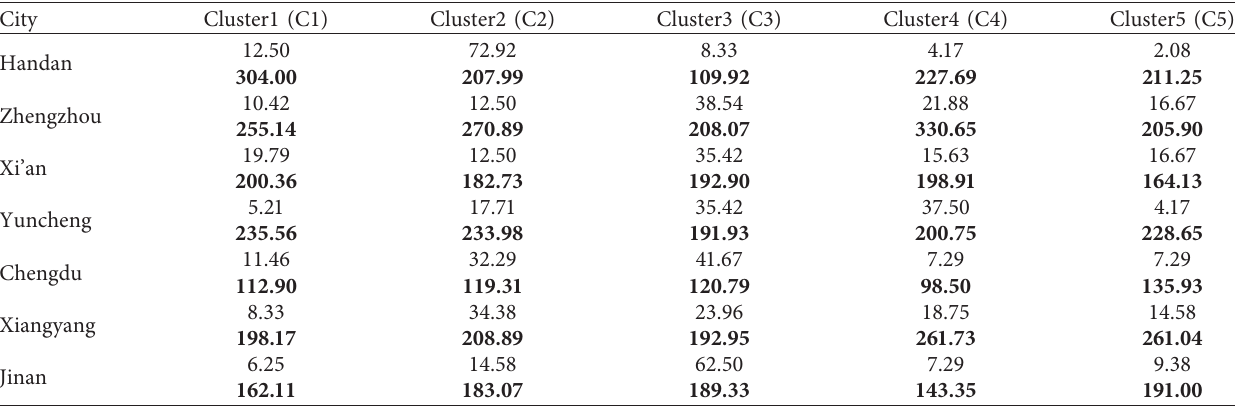
− 3) associated with the five trajectory 2.5 mean concentrations ( μ g m